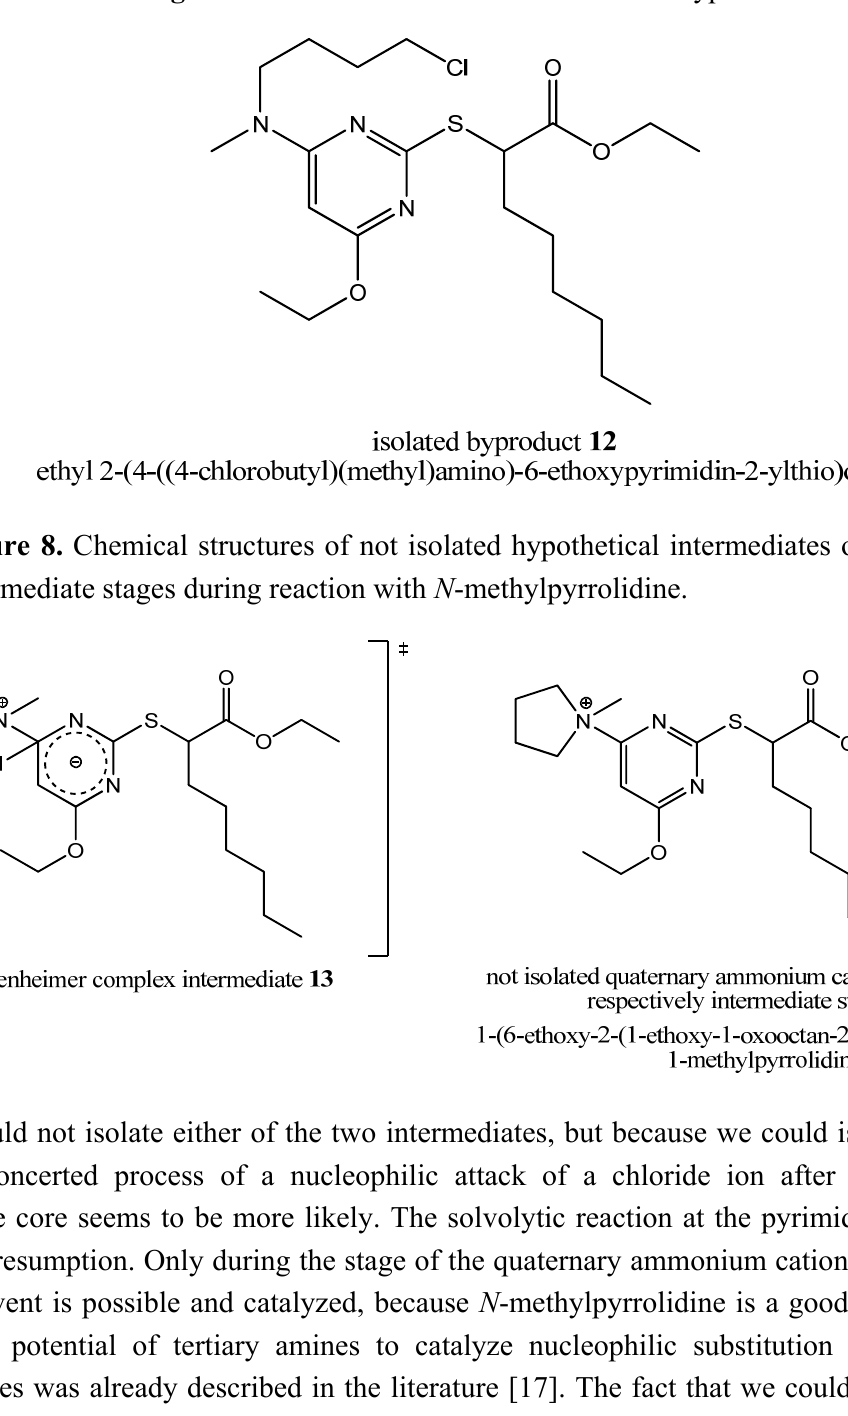
Figure 7. Chemical structure of the isolated byproduct 12 .